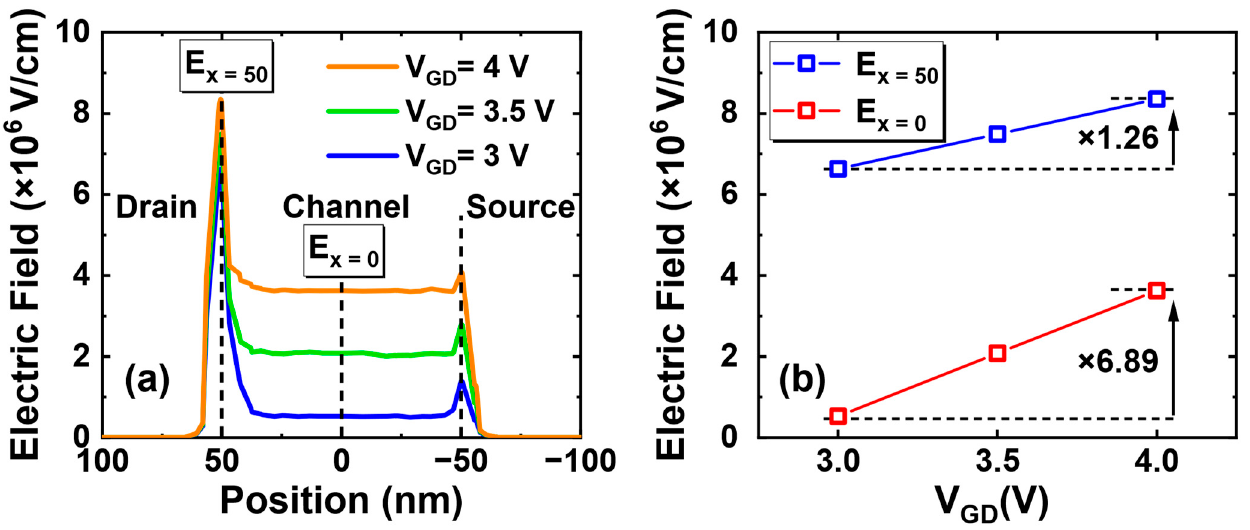
Figure 7. ( a ) Electric field distribution along the surface of the oxide layer in 2-D view under different GIDL biases (V GD = 3.0 V/3.5 V/4.0 V). ( b ) Extracted E x = 50 and E x = 0 values at different GIDL biases.